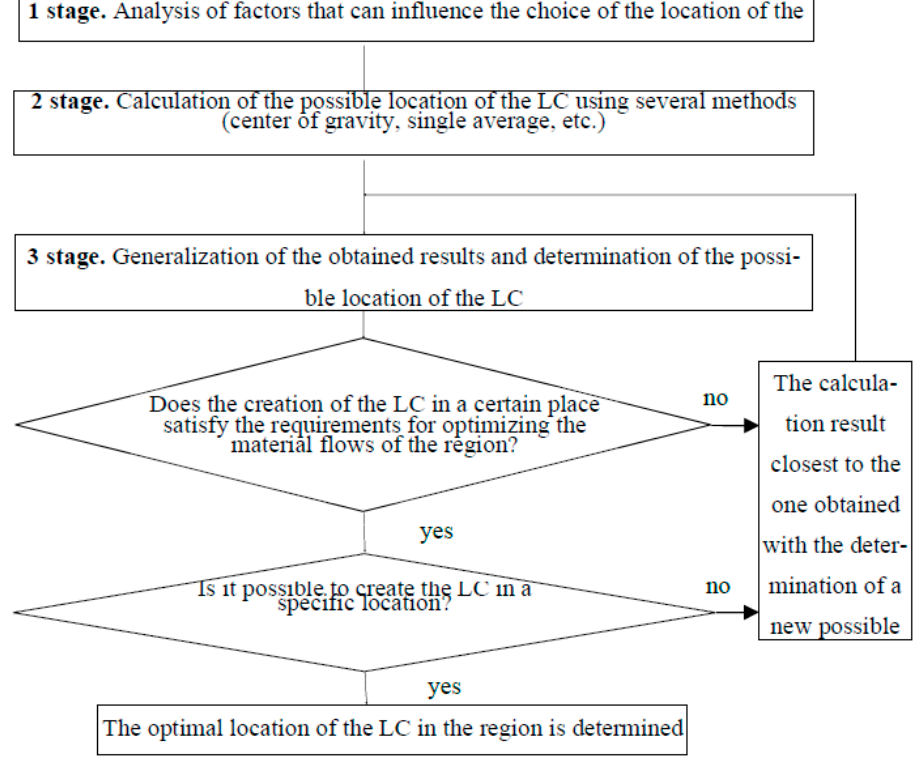
Figure 2. Algorithm for determining the optimal location of the logistics center (LC) in the region. Source: based on optimization of material streams in the region on the foundation of logistic center’s creation [60].